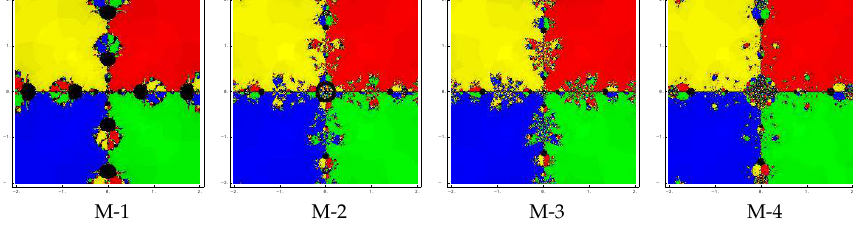
Figure 8. Basins of attraction by M-1–M-4 ( β = 10 − 4 ) for polynomial ψ 3 ( z ) .